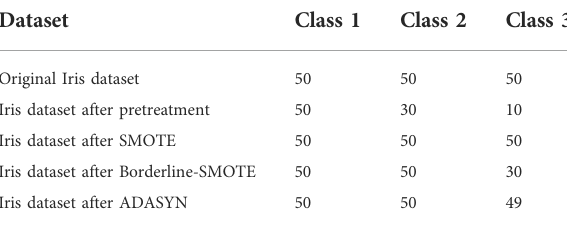
TABLE 5 Details of the class imbalanced Iris dataset and the dataset after the class balance methods